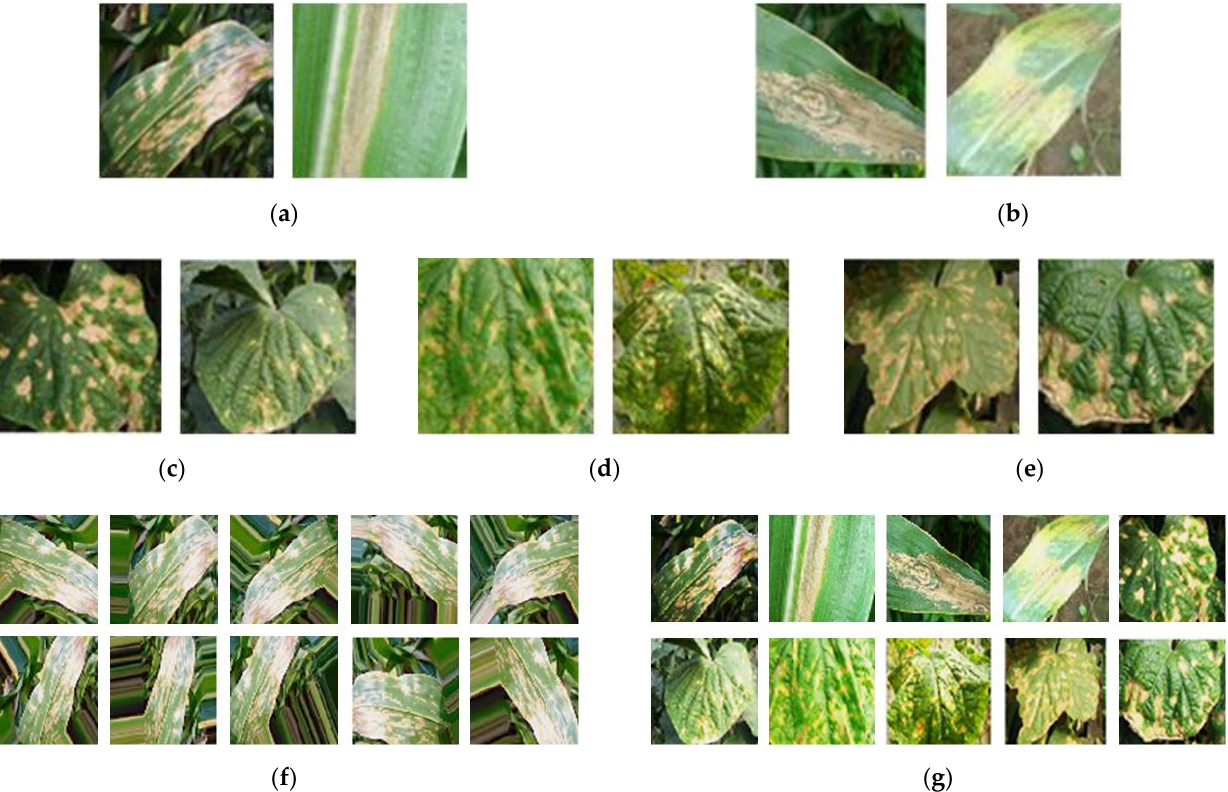
Figure 6. Five typical disease leaf images: ( a ) Original images for leaf blight of maize; ( b ) original images for brown blotch of maize; ( c ) original images for target spot of cucumber; ( d ) original images for brown spot of cucumber; ( e ) original images for anthrax disease of cucumber; ( f ) 10 augmented images of a maize disease leaf image; ( g ) equalized images of the above images in the above ( a ) – ( e ).